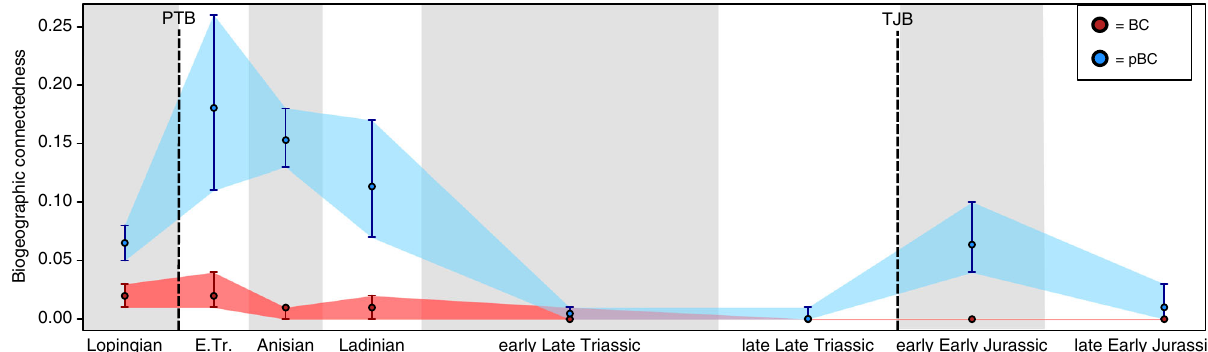
Fig. 3 Results from BC analysis of Lopingian-Early Jurassic terrestrial amniotes. Results from both non-phylogenetic (BC, red ) and phylogenetic (pBC, blue ) analyses of global biogeographic connectedness are shown. Shaded polygons represent 95% con fi dence intervals (calculated from jackkni fi ng with 10,000 replicates) for both the BC and pBC analyses. The Permian – Triassic boundary (PTB) and Triassic – Jurassic boundary (TJB) extinction events are indicated by dotted lines . E. Tr.: Early